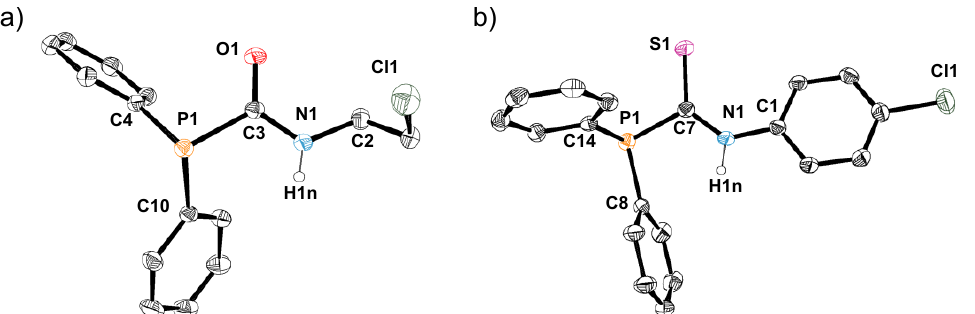
Figure 2. ORTEP drawings of ( a ) 1i (P1 molecule) and ( b ) 2c with thermal ellipsoids at 50% probability. Hydrogen atoms (except for NH protons) are omitted for simplicity. Selected bond lengths (Å) and angles (°): P1–C3 1.870(2), N1–C2 1.452(3), N1–C3 1.328(3), C3–O1 1.231(2), N1–H1n 0.81(3),